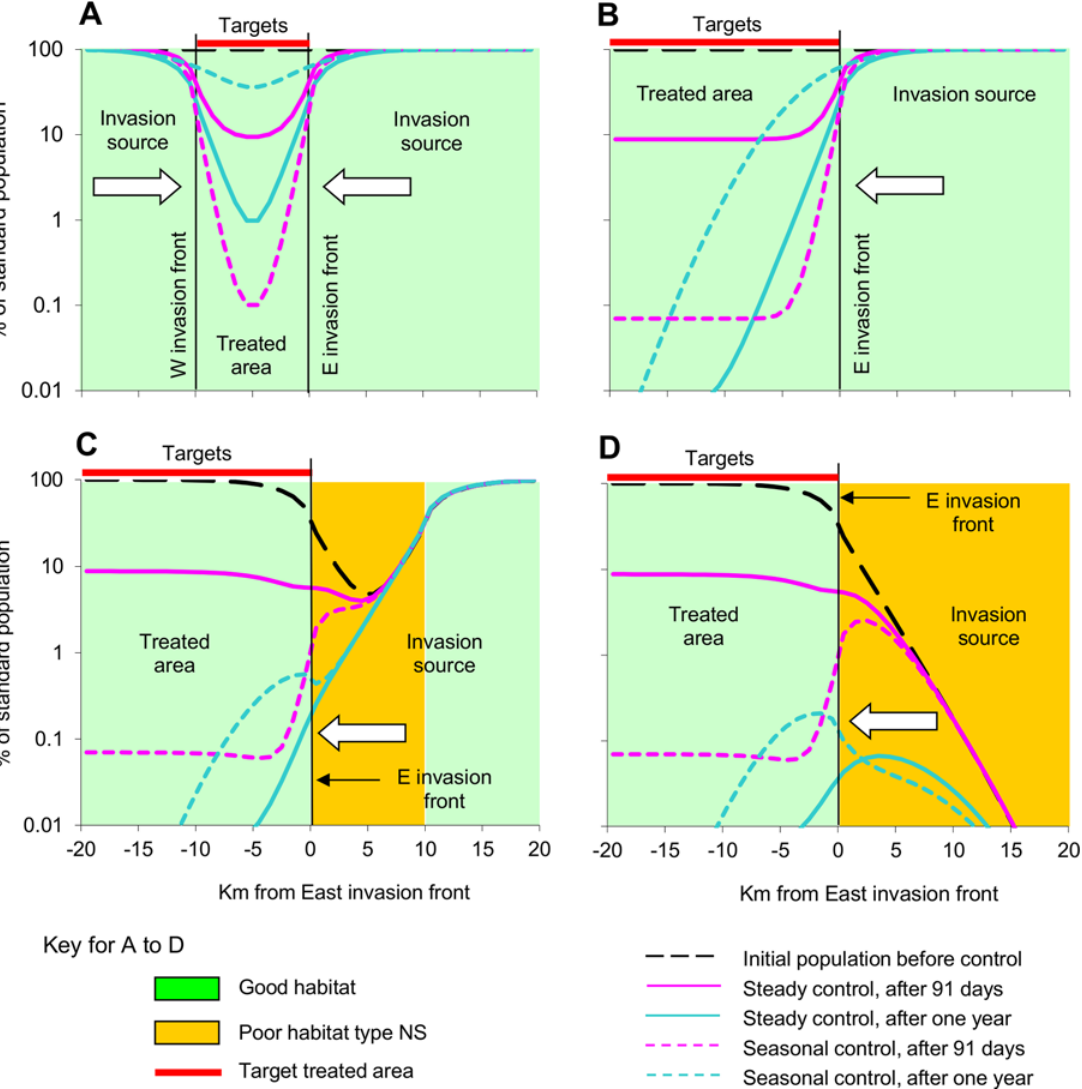
Fig 5. Population distribution at various times after starting steady or seasonal control in good non-isolated habitat, with various habitats in the invasion source. Population density of tsetse, as a percent of the standard density, at various distances from the invasion front, at different times after the start of normal steady or standard seasonal control, in an area where the invasion source was all good habit adjacent to a treated area spanning 10km (A) and > 40km (B), or where the treated area spanned > 40km of good habitat and the invasion source had a 10km (C) and > 40km (D) segment of poor habitat type NS. For normal steady control the daily kill rate was fixed at 5%. For standard seasonal control the rate was 15% for the first three months, followed by a linear decline to zero in the next three months. White arrows indicate the direction of invasion.